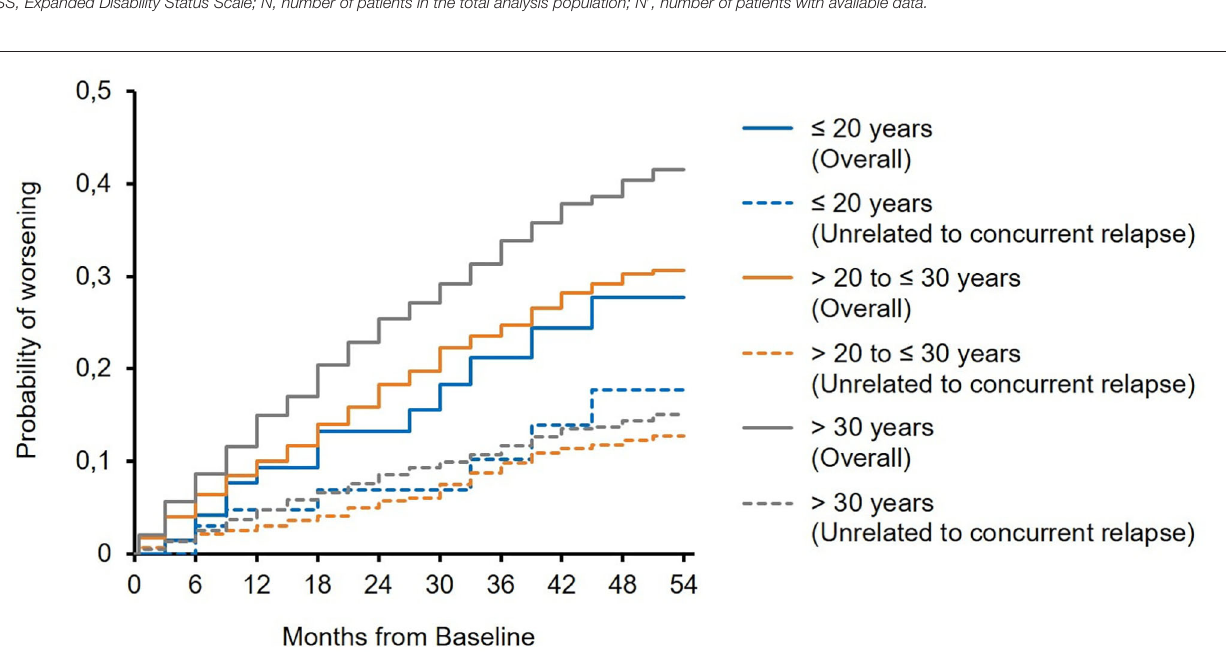
and serious respiratory tract infections (1.2% and 2.5 vs.